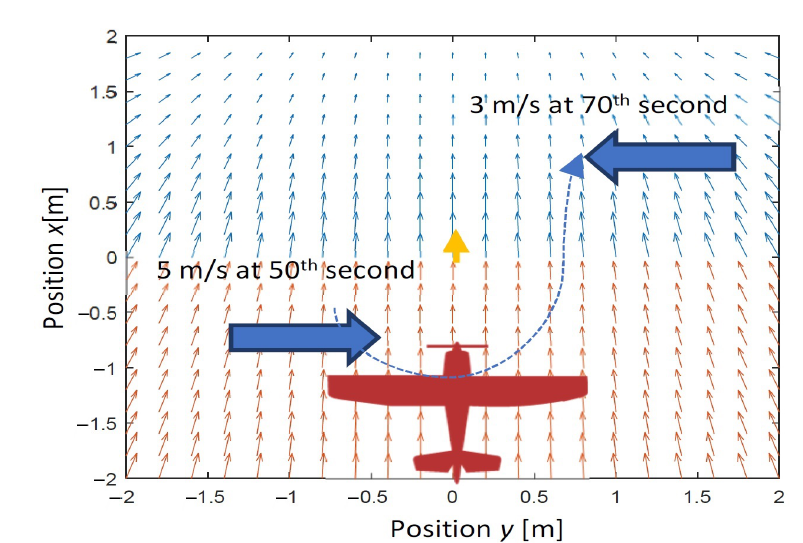
Figure 6. The first scenario of simulations for lateral wind gust